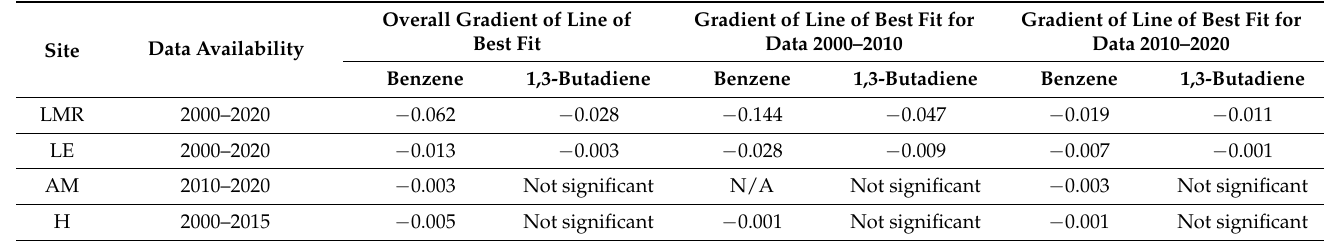
Table 1. Summary table of graphical analyses for each site across the whole available dataset and split into decadal subsets. Where trend proved to be statistically insignificant ( p > 0.05), label of ‘Not significant’ was used. N/A label used where data was unavailable for a